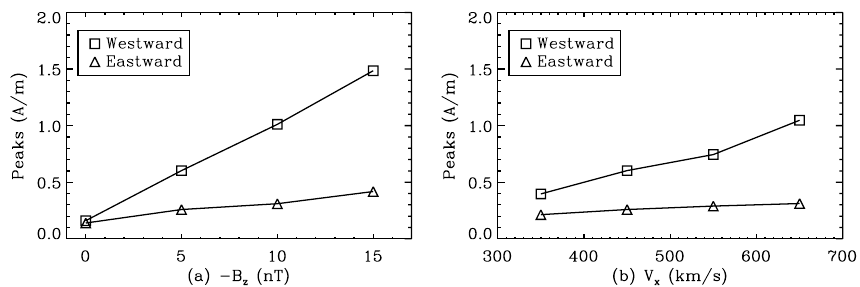
Fig. 7. (a) Peak values of the westward electrojet and eastward electrojet as a function of the southward IMF magnitude. (b) Peak values of the westward electrojet and eastward electrojet as a function of the solar wind velocity. In the graphes the peak values of eastward electrojet are indicated by triangle symbols, the peak values of westward electrojet are indicated by square symbols.